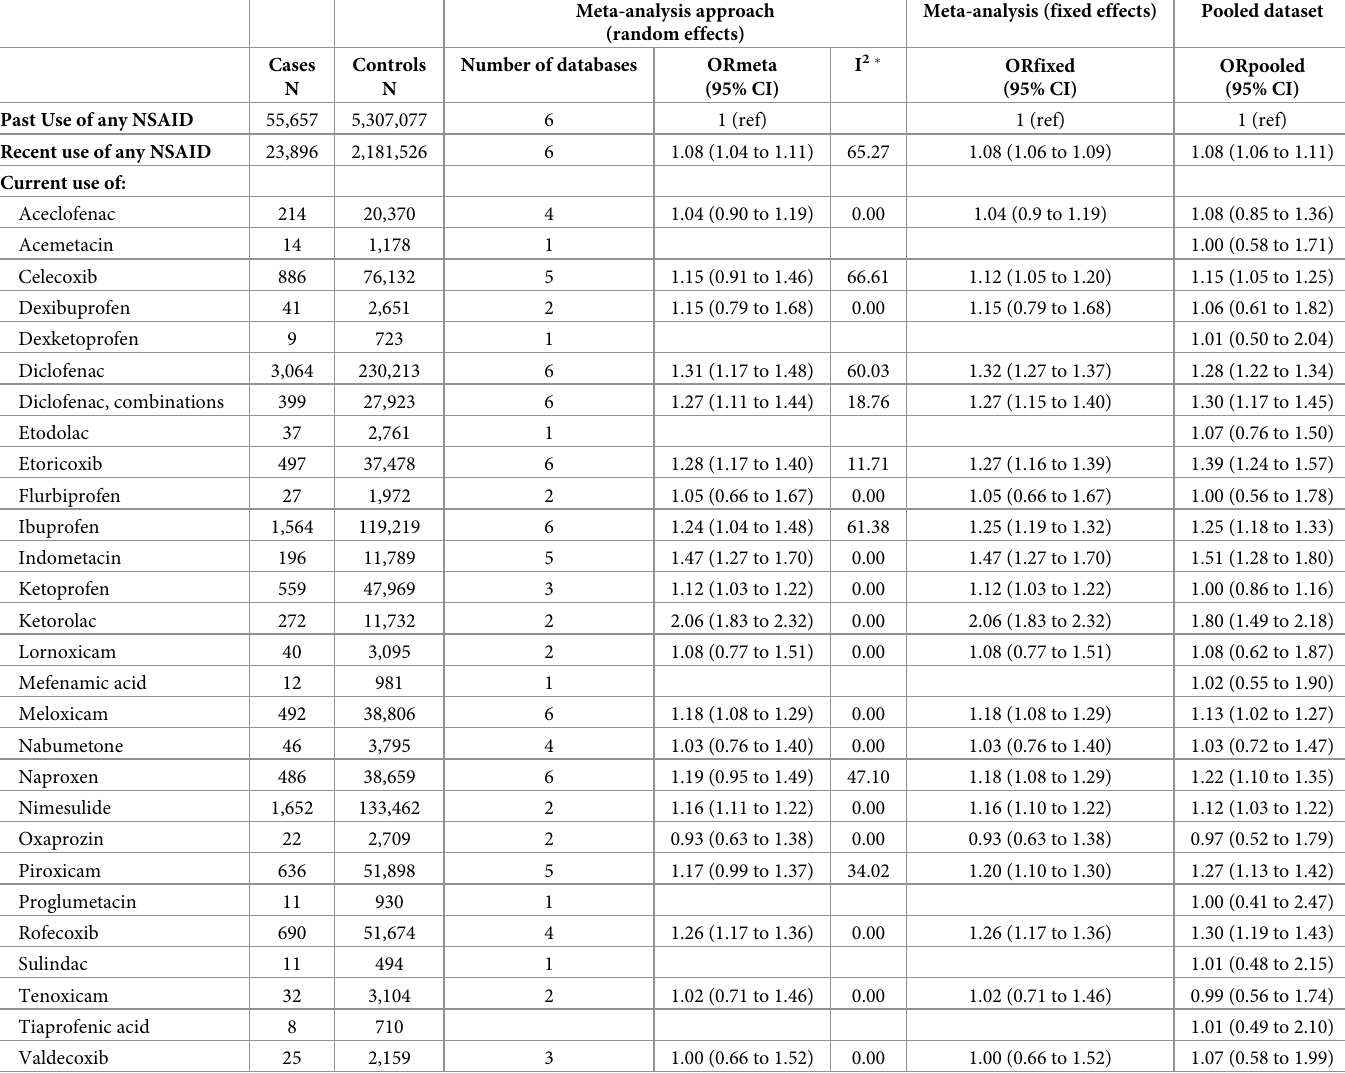
Table 2. Association between current use of an individual NSAID and risk of AMI compared with past use of any NSAID pooled by meta-analysis approach (ran- dom and fixed effects) and by unweighted (matched set) pooled